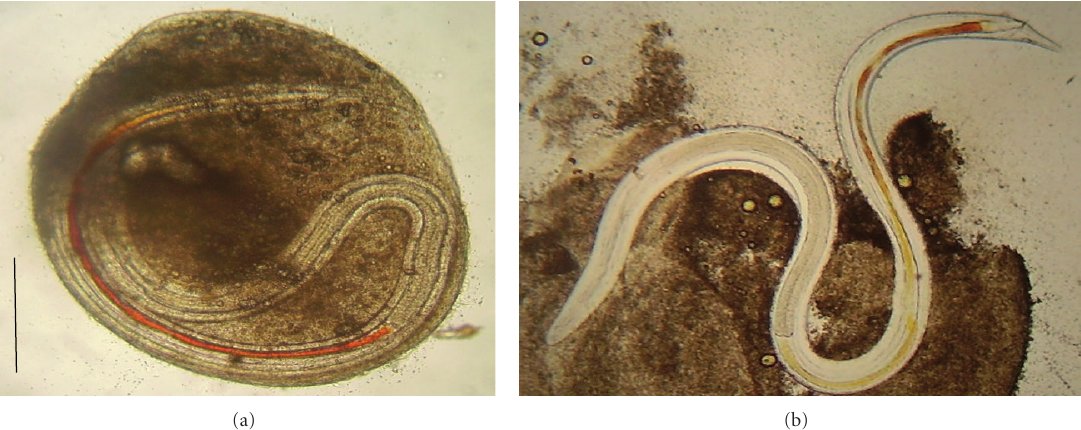
Figure 2: (a), Nematode cyst type I (intact); (b), mechanically excysted larva. Scale bar: 0.2 mm.